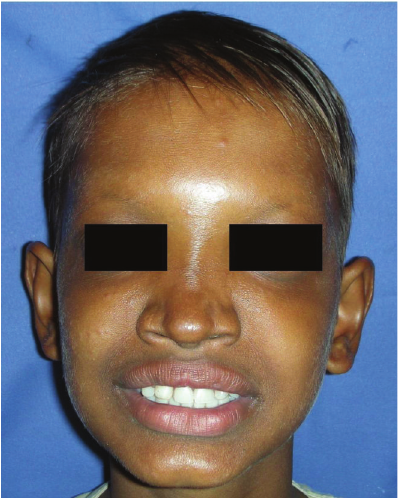
Figure 7: Post insertion Extraoral